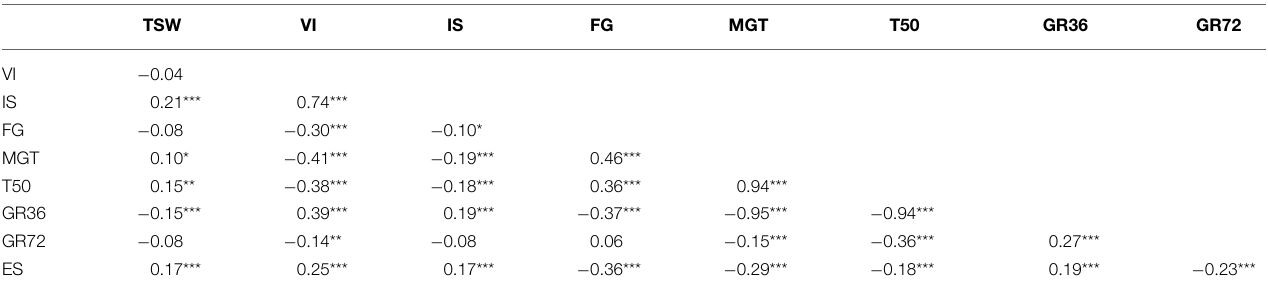
TABLE 2 | Correlation coefficients (r) for different trait pairs associated with seed germination performance measured in two seed lots (SL2011 and SL2012) from an oilseed rape diversity panel ( n = 248